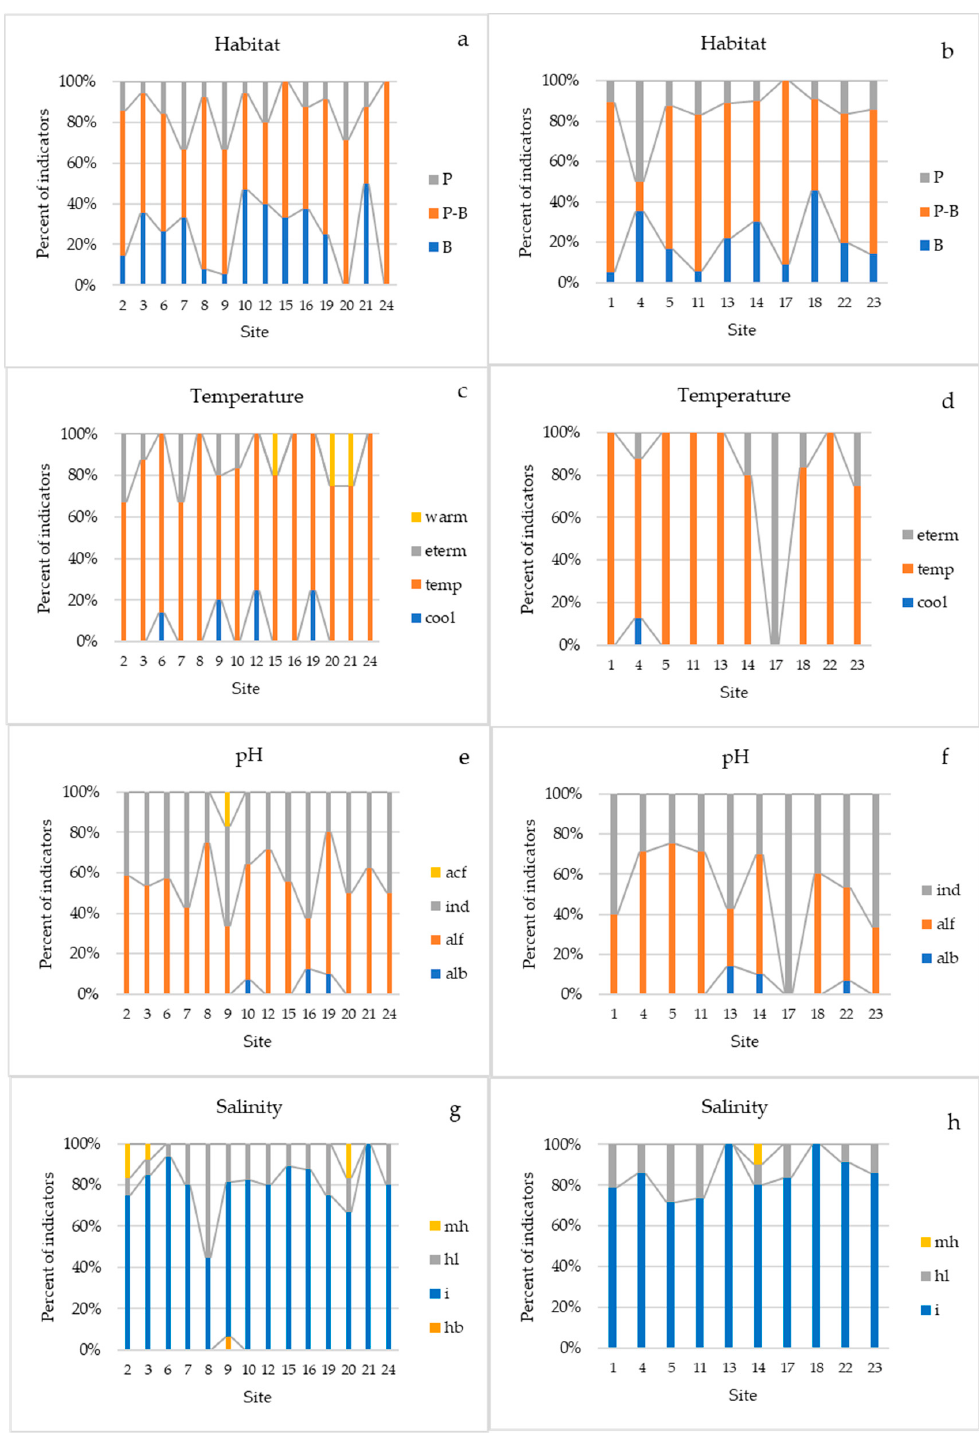
Figure 7. Ecological characteristics of phytoplankton species indicators (habitat, temperature, pH, salinity) grouped according to the size of rivers, S and M ( a , c , e , g ) and L and XL ( b , d , f , h ), within the Ukrainian part of the Siversky Donets river basin. Abbreviations of ecological groups: by habitat, P—planktonic, P-B—plankto-benthic, B—benthic; by temperature, cool—cool water, temp—temperate, eterm—eurythermic, and warm—warm water; by pH, alb—alkalibiontes, alf—alkaliphiles, ind—indifferents, and acf—acidophiles; by salinity, hb—oligohalobes-halophobes, i—oligohalobes-indifferents, mh—mesohalobes and hl—halophiles.